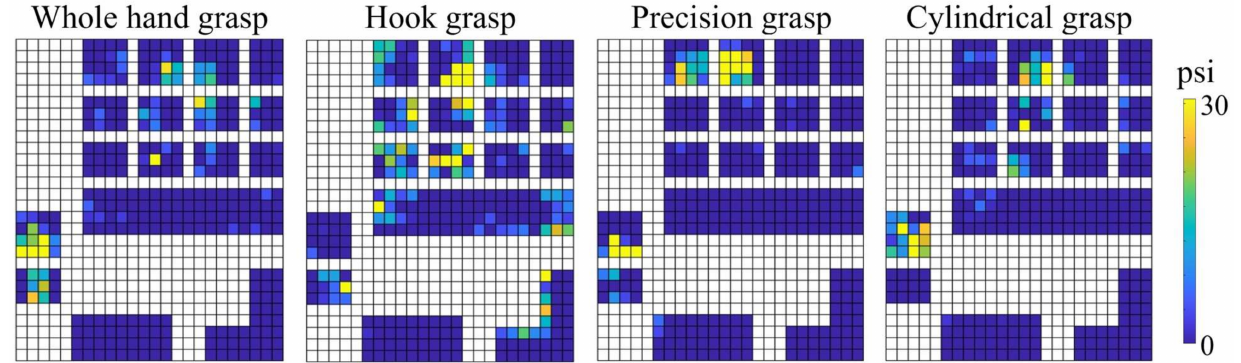
Figure 3. Force distribution of four grasp types of Subject 3 (for object weight 170 g). The whole hand grasp (ball) and cylindrical grasp (water bottle) are mostly concentrated at the fingers. The dominant fingers for precision grasp (bottle cap) are the tips of the thumb, index and middle fingers. Hook grasp (door handle) requires both palm, thumb and fingers. The scale psi indicates pound force per square